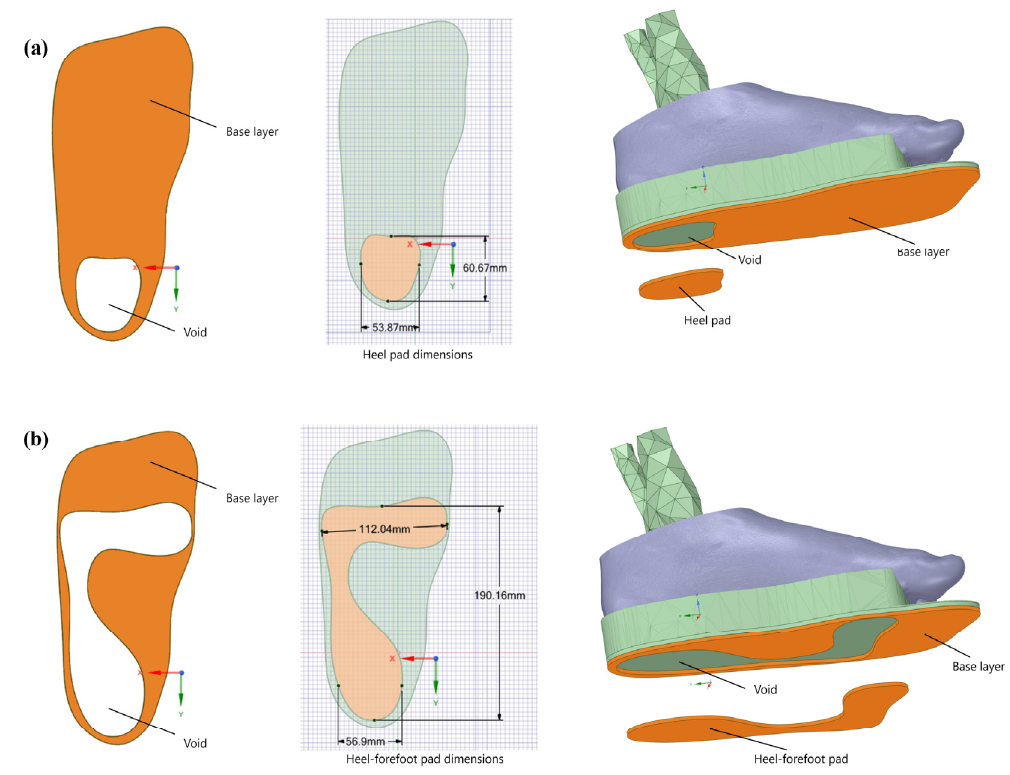
Figure 1. The pad designs. ( a ) Heel pad and ( b ) heel–forefoot pad added to the base layer. The pad was embedded in the base layer of the CMI with varying material properties (Table 1). Ansys SpaceClaim (ANSYS Inc., Canonsburg, PA, USA) was used to create a 3D foot model with the CMI and with various pad designs for a diabetic foot with